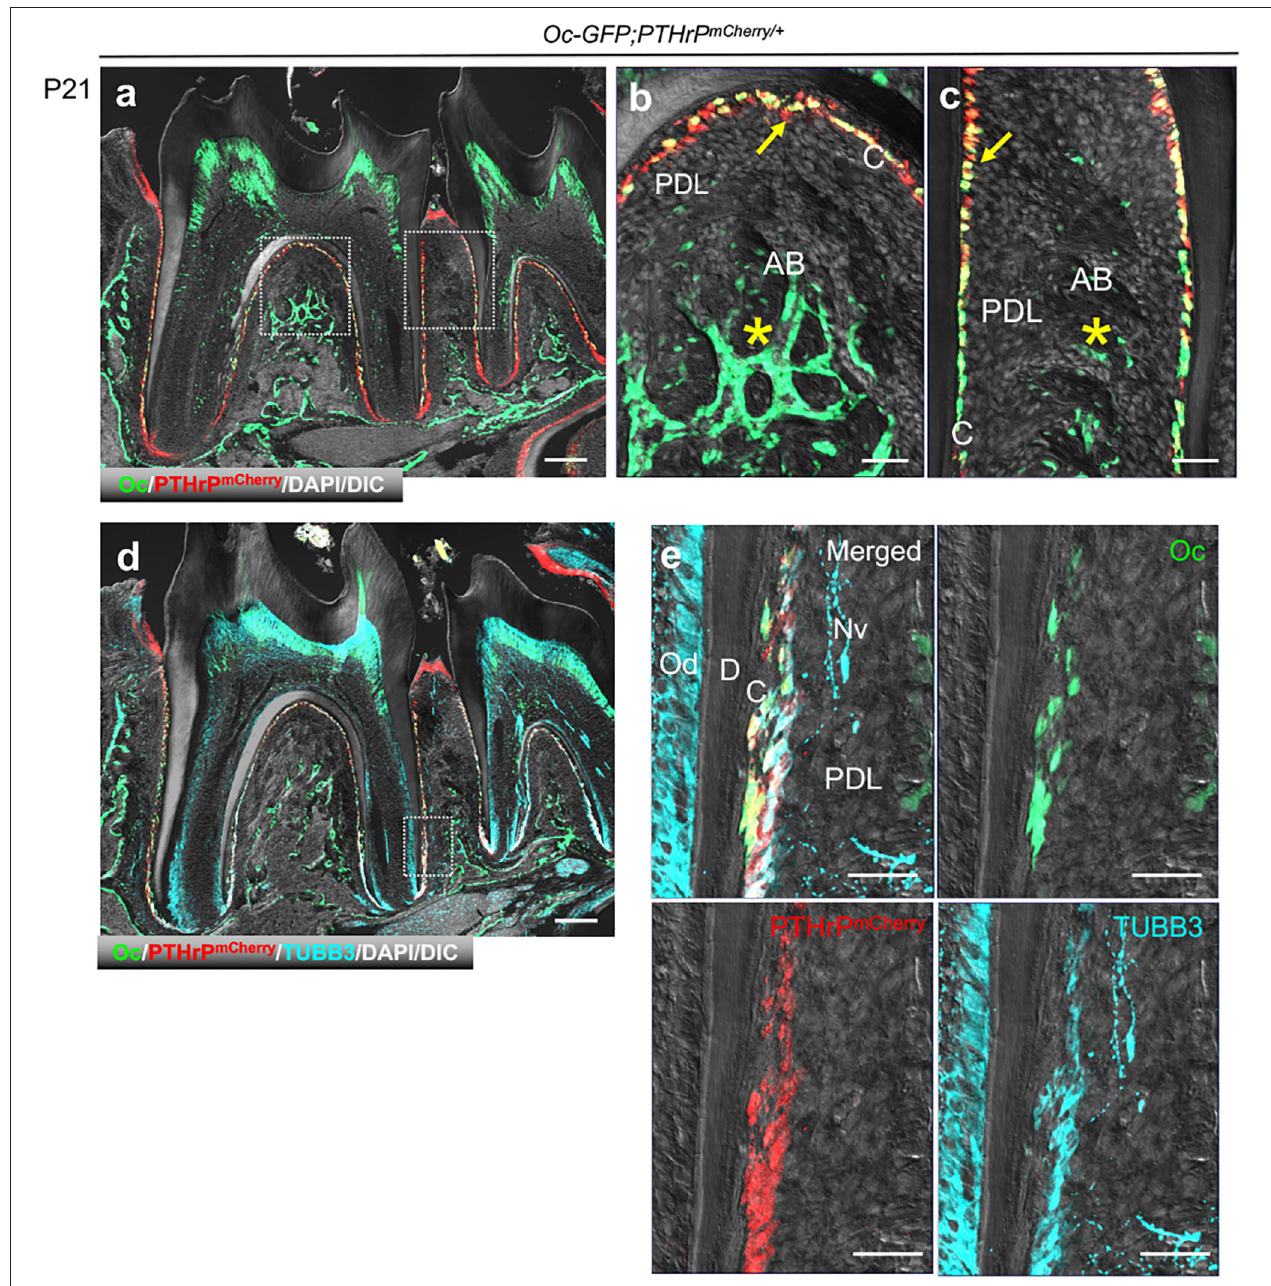
FIGURE 4 | PTHrP is expressed by cementoblasts, but not osteoblasts. (a–e) Mandibular molars of Osteocalcin(Oc) - GFP;PTHrP mCherry . C: cementoblast, PDL: periodontal ligament, AB: alveolar bone, Nv: nerve, D: dentin, Od: odontoblast. Arrow: PTHrP-mCherry + Oc-GFP + cementoblasts, *: Oc-GFP + osteoblasts. Scale bars: 200 µ m (a,d) , 50 µ m (b,c,e)